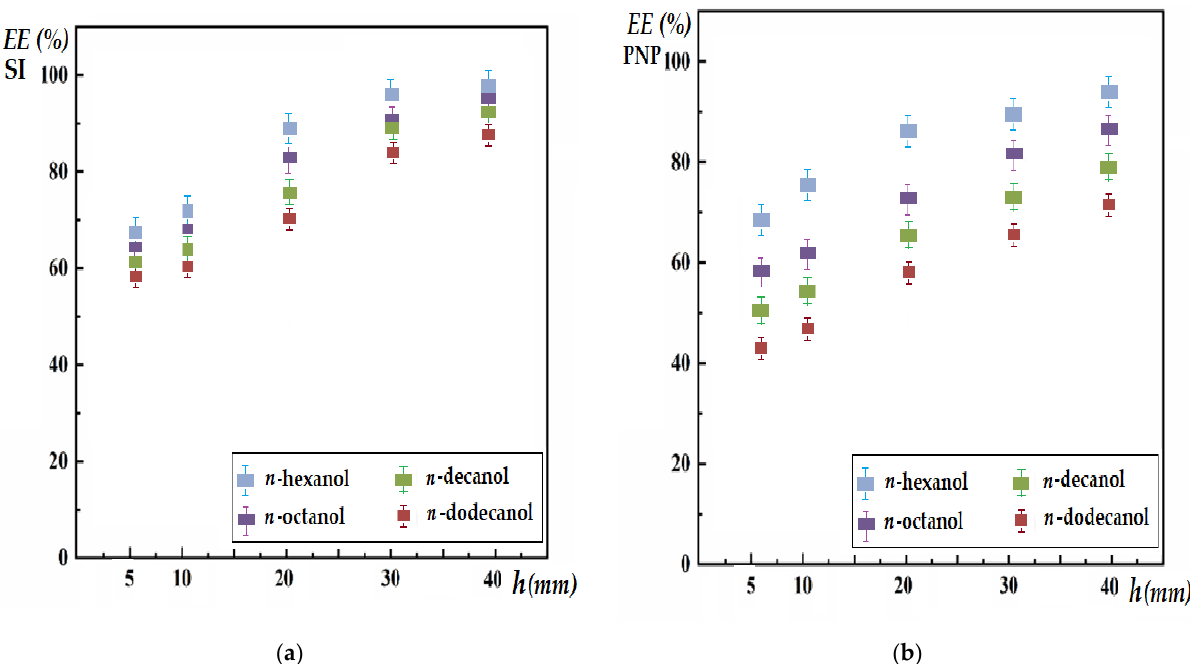
Figure 7. The efficiency of the separation after 3 h of silver ions (SI) and p -nitrophenol (PNP), de- pending on membrane thickness, rotation speed of the magnetic rods and the nature of the solvent: ( a ) membrane thickness at the extraction of SI; ( b ) membrane thickness at the extraction of PNP.